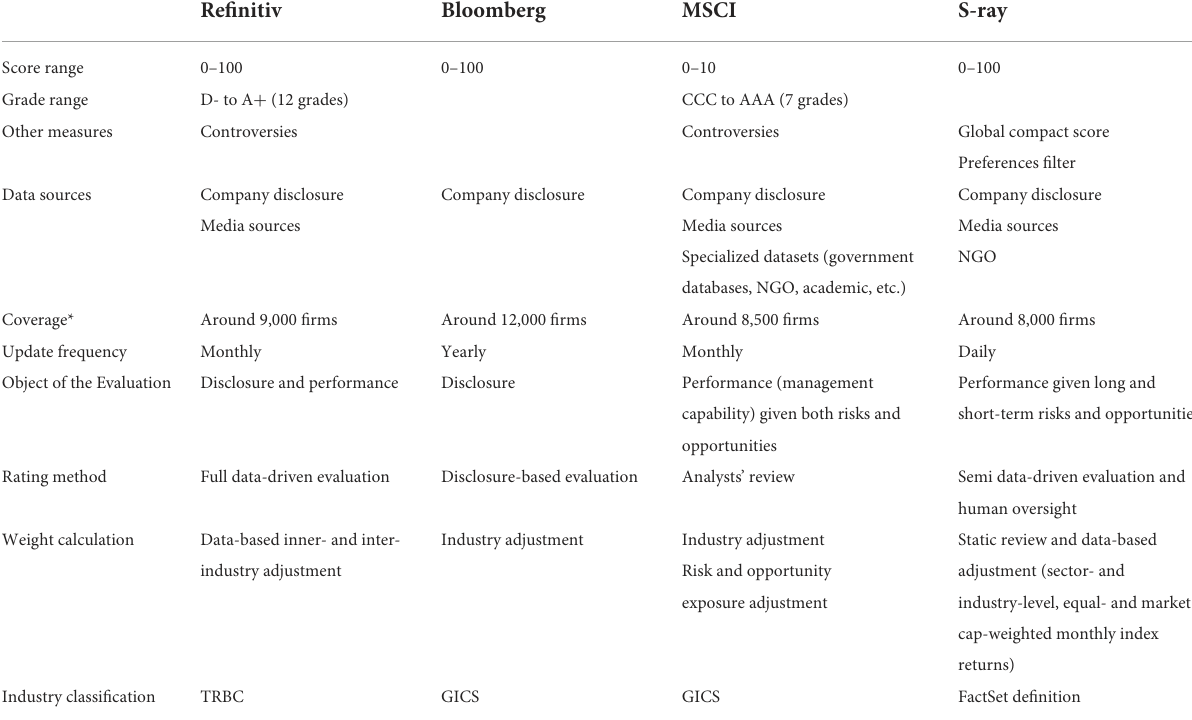
TABLE 3 Summary of methodology across ESG